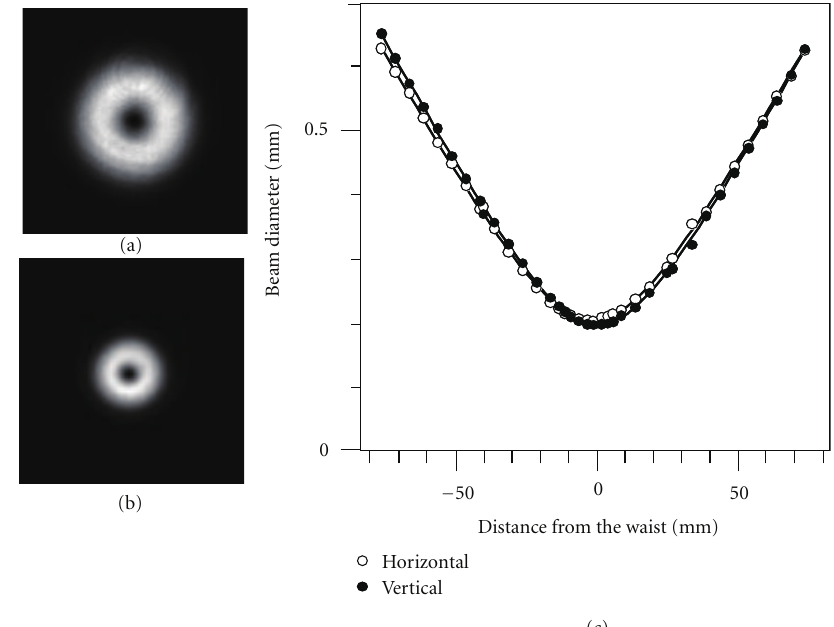
Figure 5: Recorded intensity distributions (a) before the waist by 4 times of Rayleigh length and (b) at the waist, respectively. (c) The variations of the beam diameters as a function of the distance from the waist. Open and filled circles indicate the horizontal and vertical beam widths, respectively. Fitting curves are depicted by solid lines.